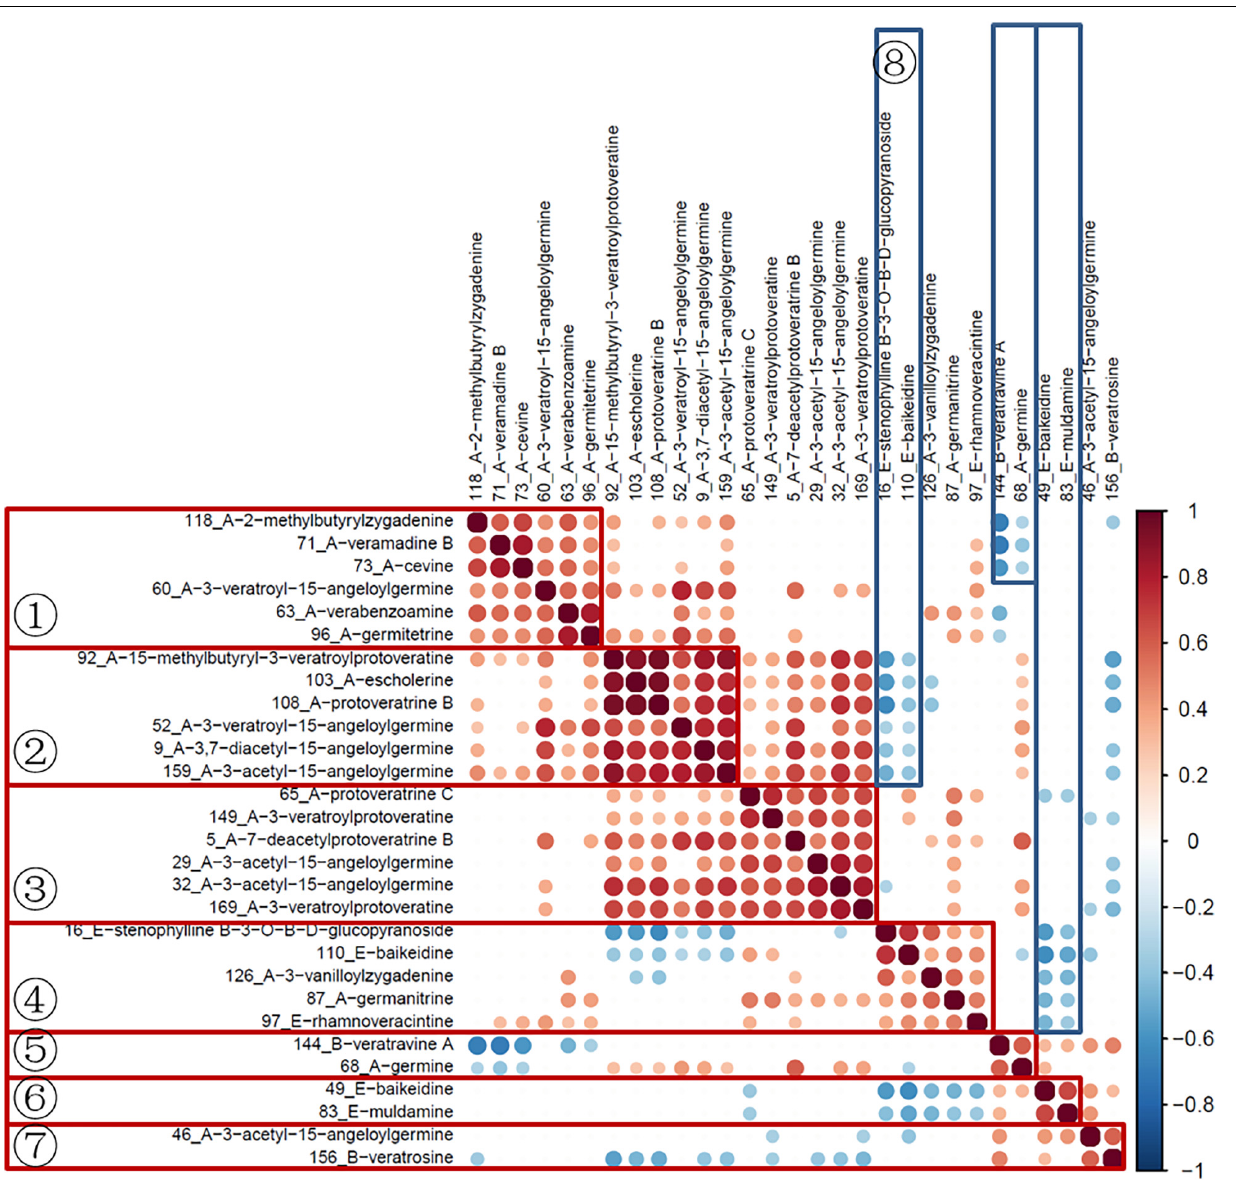
FIGURE 5 | Correlation analysis of selected variables used in MRM